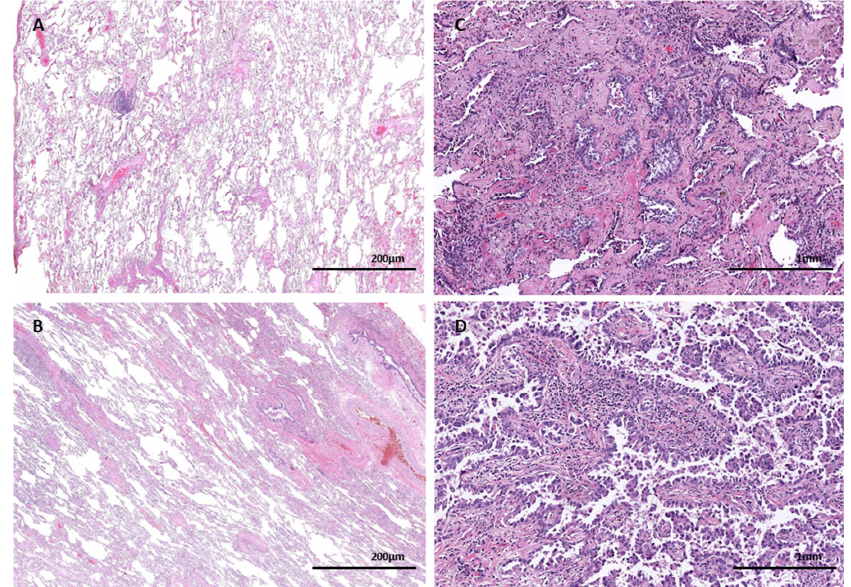
Figure 2. Hematoxylin-eosin staining of two cases with mutations in both non-tumoral lung tissue and lung adenocarcinoma: ( A ) non-tumoral lung sample of patient with EGFR mutation (2 × ) and ( C ) lung adenocarcinoma sample of the same patient (10 × ); ( B ) non-tumoral lung sample of patient with KRAS mutation (2 × ) and ( D ) lung adenocarcinoma sample of the same patient (10 ×